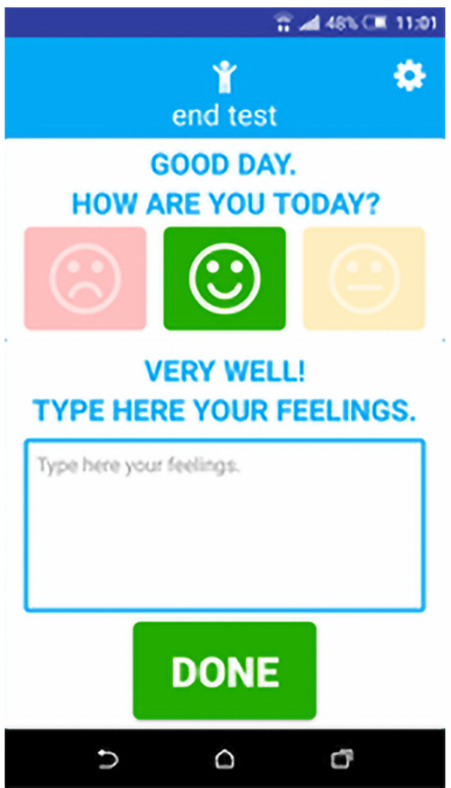
Figure 6. End-user alert.